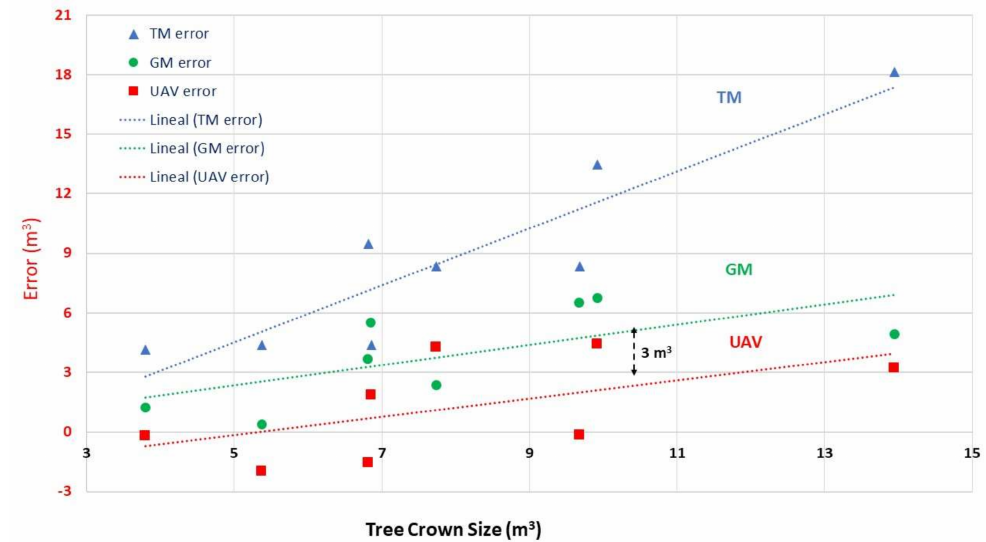
Figure 18. Volume error (m 3 ) related to absolute tree crown size.